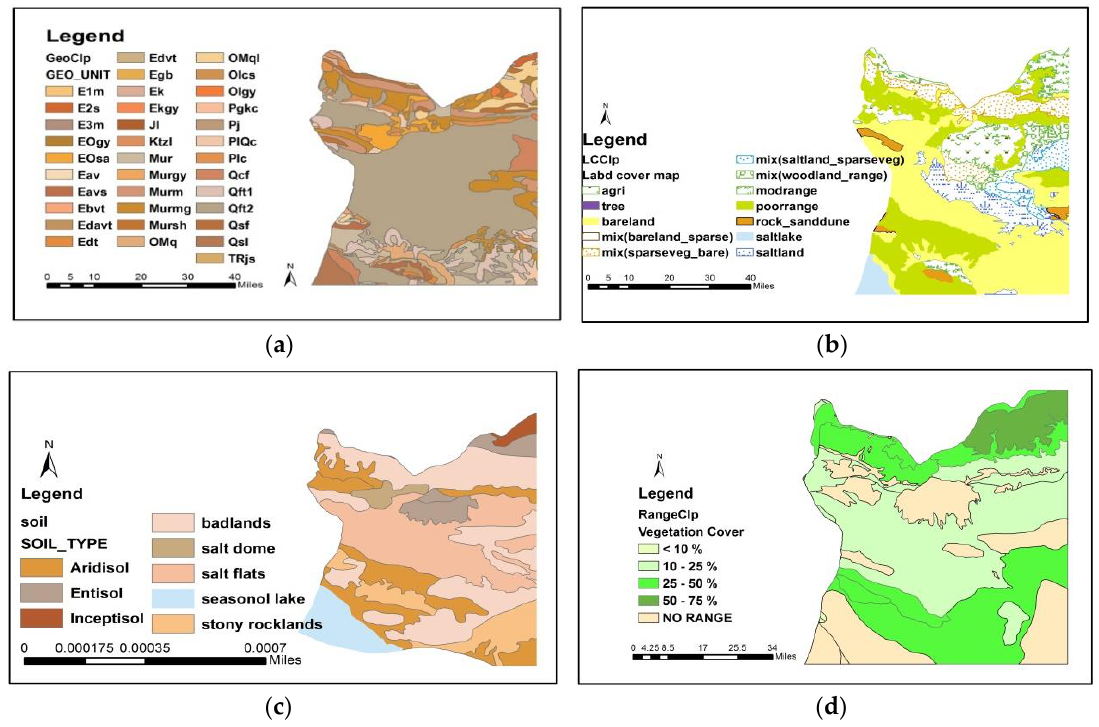
Figure 6. Examples of ( a ) geology map and ( b ) land cover map; ( c ) soil map and ( d ) vegetation cover map. Table 2. A frame of the attribute table of soil type and soil regime map in the geospatial database.